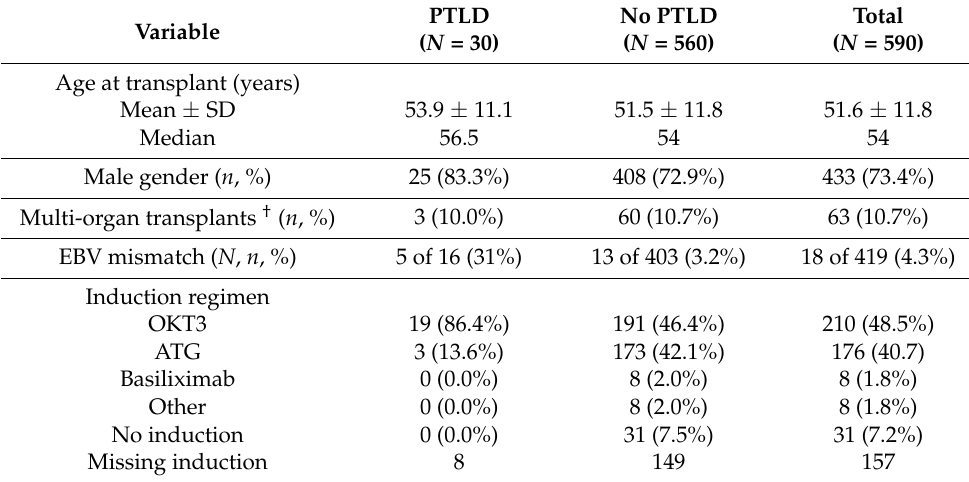
Table 1. Baseline